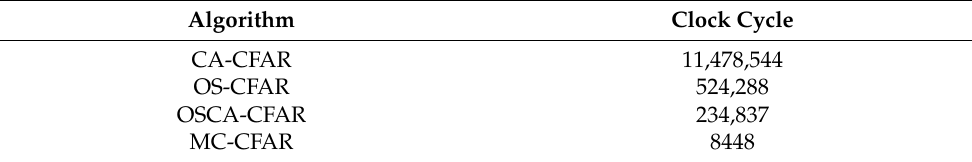
Table 5. Algorithm running clock cycles (time